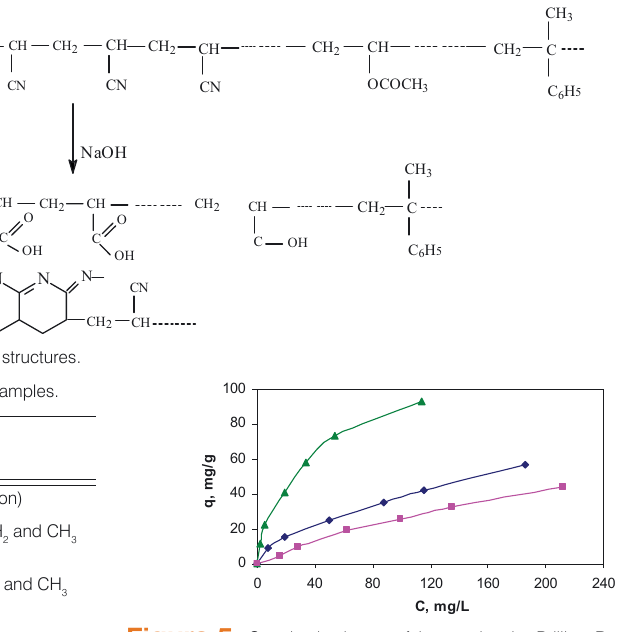
Figure 5. Sorption isotherms of the reactive dye Brilliant Red HE-3B on HPANat ▲ 45°C, ■ 20°C and ■ 5°C.